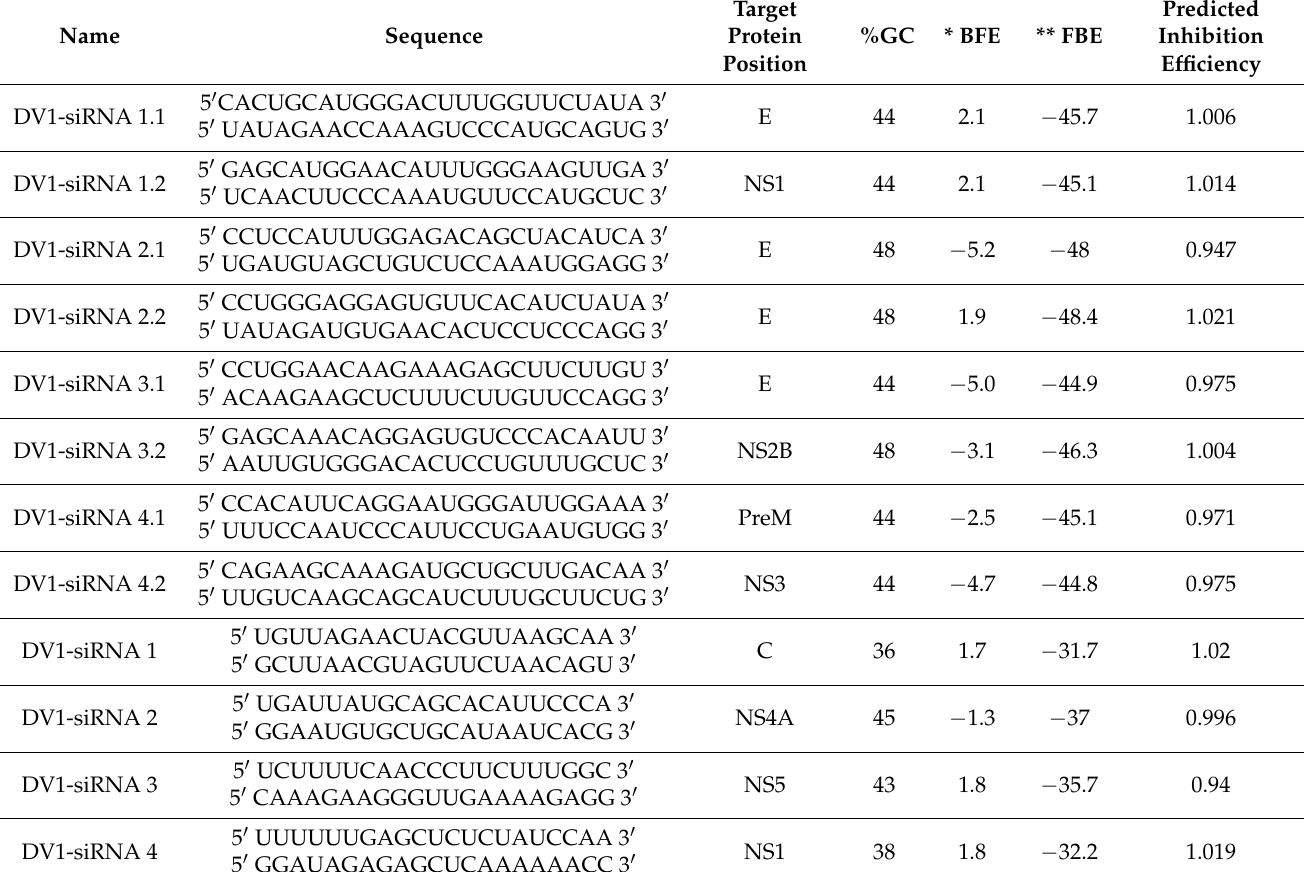
Table 1. Overall parameters of the siRNA